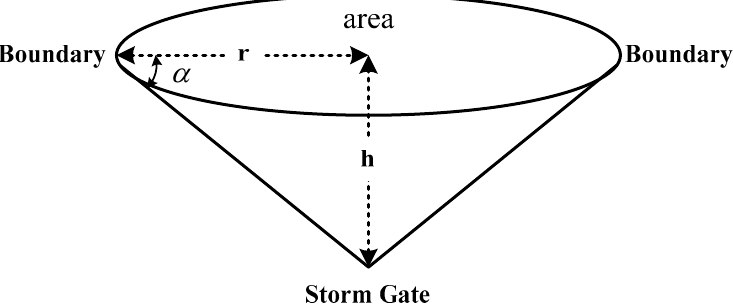
Figure 2. Drainage basin cone and the related parameters.